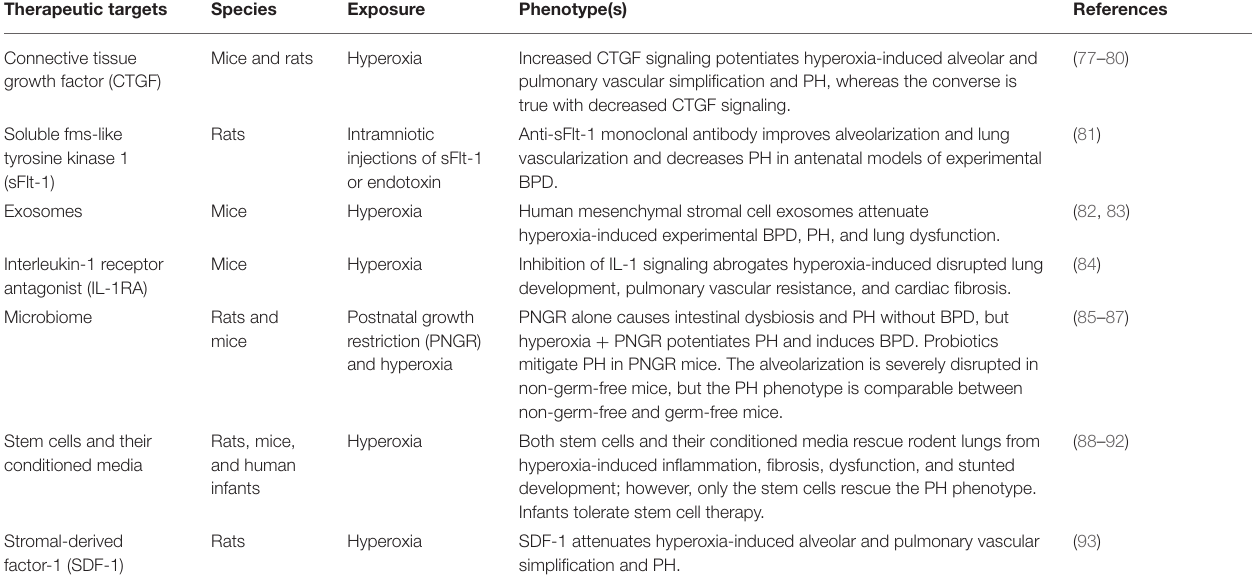
TABLE 1 | Overview of the novel therapeutic interventions in experimental bronchopulmonary dysplasia and pulmonary